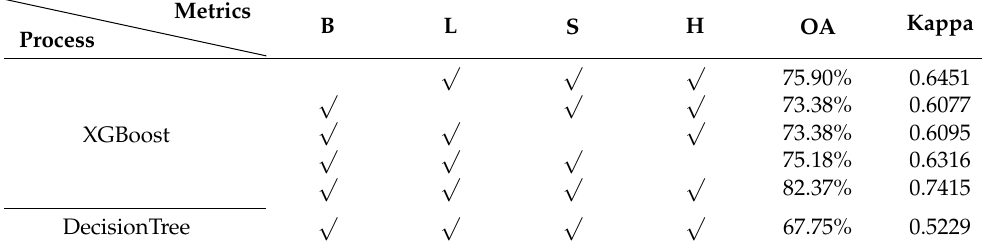
Table 5. Comparison of different metric sets and methods.